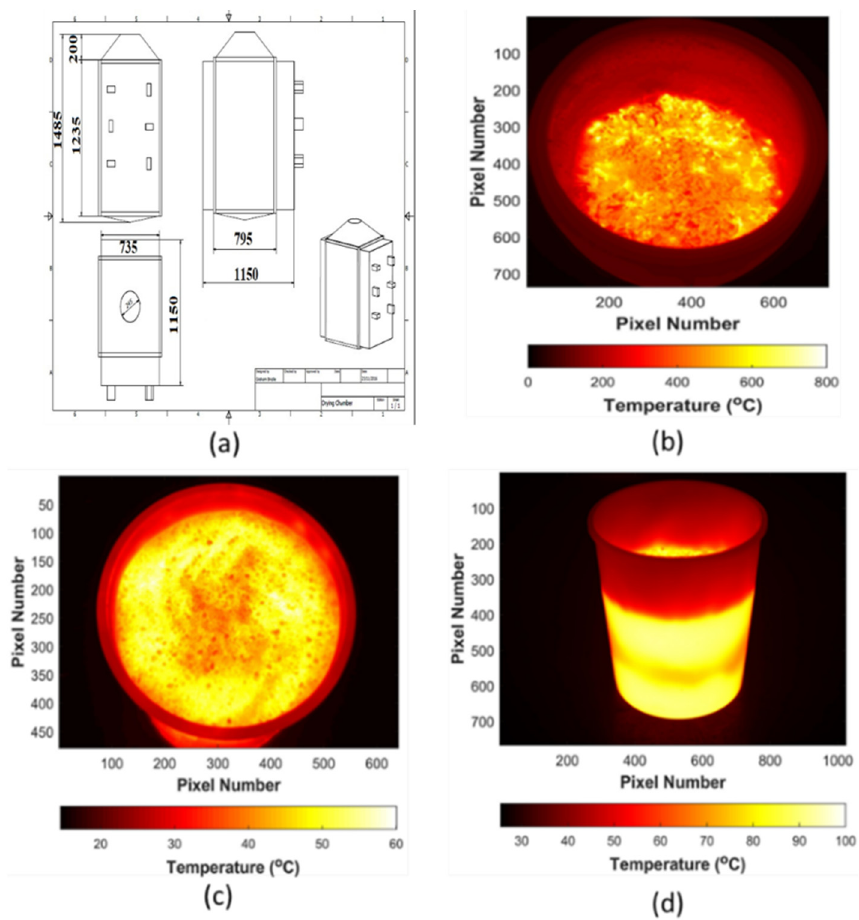
Figure 1. ( a ) Schematic diagram of a 6 kW microwave (MW) chamber used for soil treatment and biochar preparation, ( b ) a thermal image of sawdust biochar in a quartz crucible showing the pyrolysis temperature, ( c ) top view thermal images of soil heating after MW irradiation showing the temperature increase of 55 °C ± 5 °C, and ( d ) side view thermal images of soil heating after MW irradiation showing the temperature increase of 85 °C ± 5 °C.